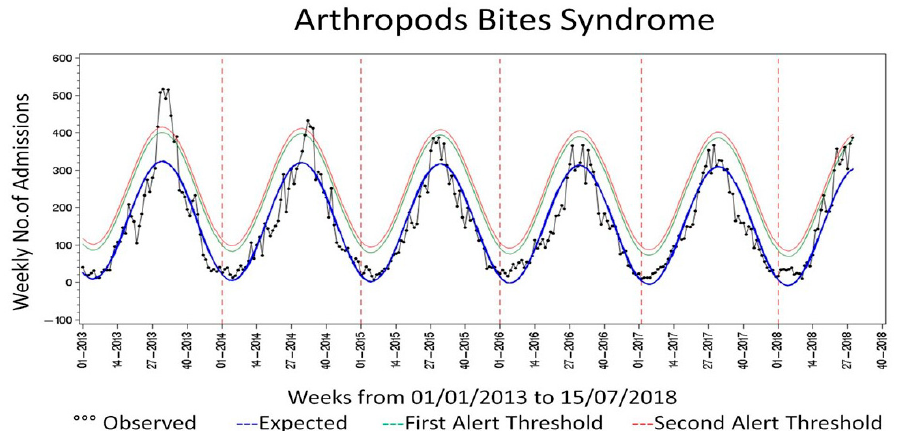
Figure 2. Number of ED admissions, expected value and alert threshold for Arthropod bites syndrome. Blue Line, Expected number of ED admissions; Green Line, upper 95% confidence interval for the expected number of ED admissions (first alert threshold); Red Line, upper 99% confidence interval for the expected number of ED admissions (second alert threshold).